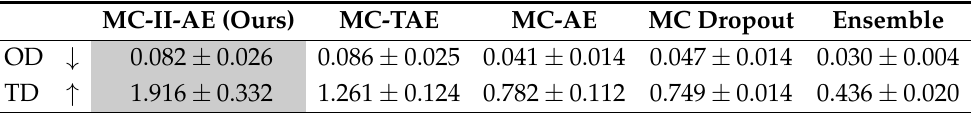
Table 7. We calculated the sum of the Wasserstein distances between D in (in-distribution) and all D out (TD, larger is better) separately and the sum of the distances between D out (out-of-distribution) CIFAR10 and all other D out (OD, smaller is better) over 10 runs. We report the mean and standard deviation and compare our method (MC-II-AE) against MC dropout and an ensemble of models (Ensemble) as well as vanilla (AE) and triplet autoencoders